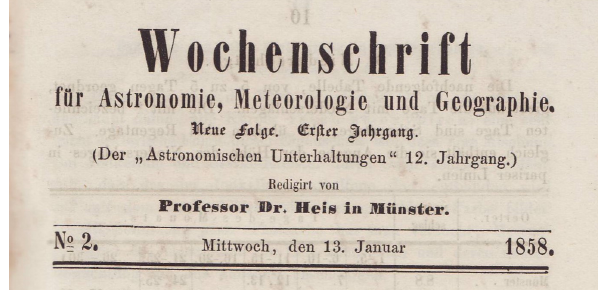
Figure 5. Wochenschrift für Astronomie, Meteorologie und Geogra- phie , edited by Heis.